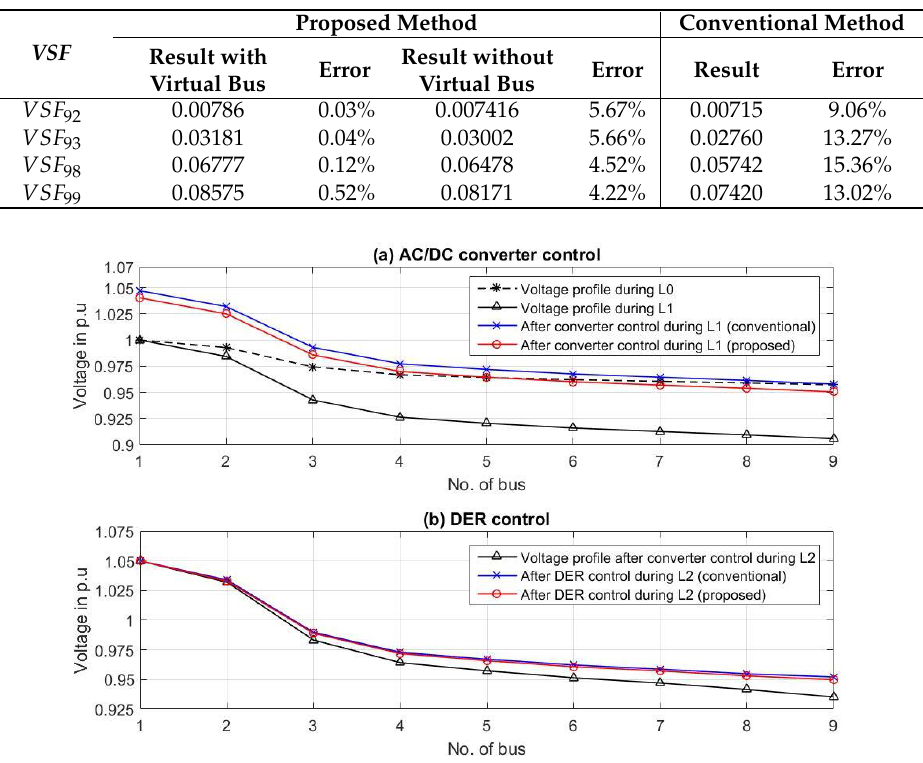
Figure 12. Voltage profile of the LVDC system under voltage control method (Case 2). (a) with AC/DC converter control; (b) with distributed energy resource control after AC/DC converter control.